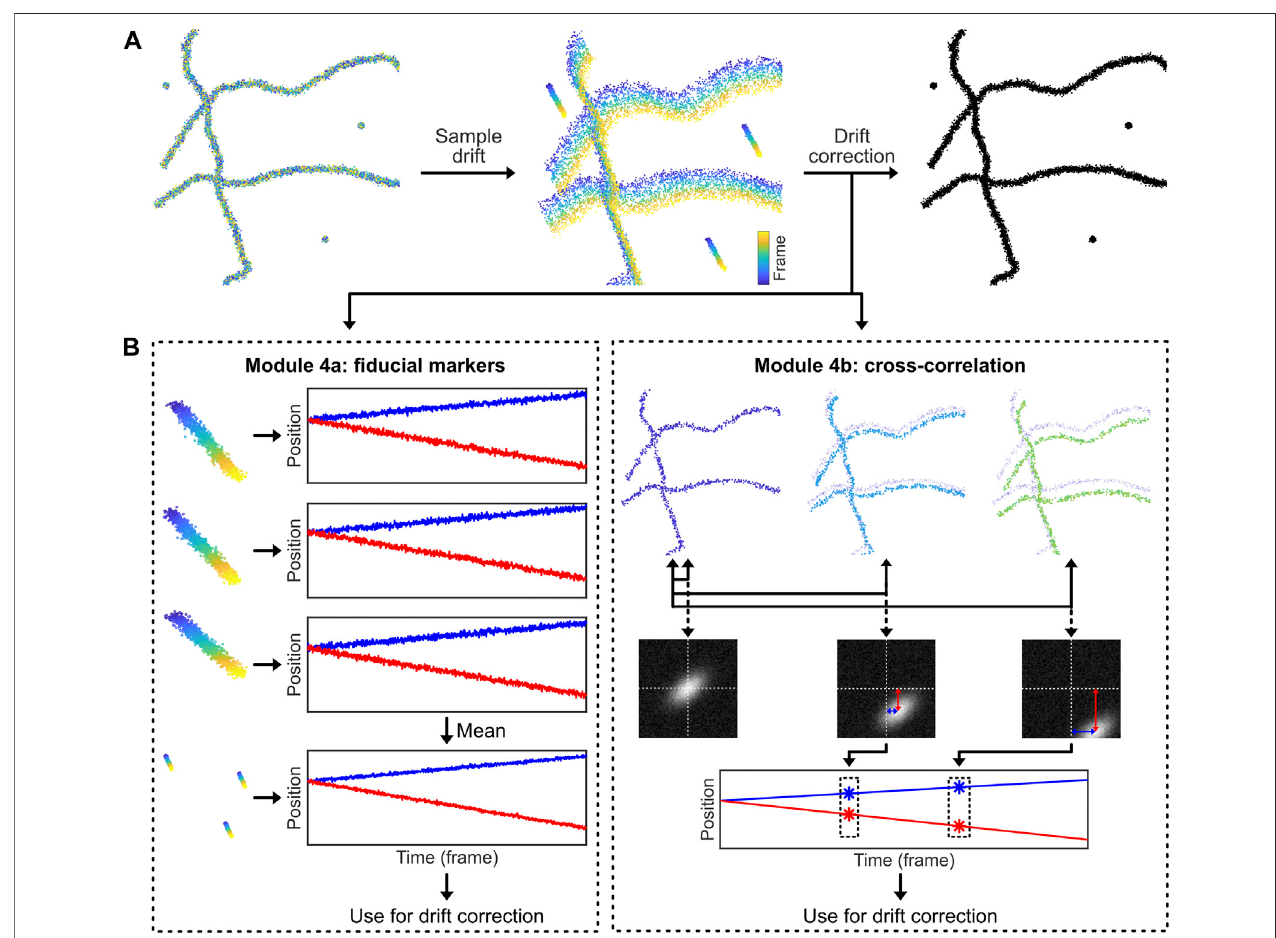
FIGURE 4 | Drift correction methodologies. Most SMLM experiments exhibit sample drift, so the localizations obtained from each fl uorophore depend on their detection time within the SMLM acquisition. The reconstructed SMLM image, which combines all localizations from the SMLM experiment, is therefore affected by the overall drift, which directly affects the structural resolution and as such can introduce misleading artifacts (e.g. smearing clusters to fi laments). Drift correction methods correct this. (A) : Drift can be corrected by introducing fi ducial markers that can be tracked with high precision. (B) : Alternatively, the displacement of the biological structure at different time points can be analysed via temporally cross-correlating the